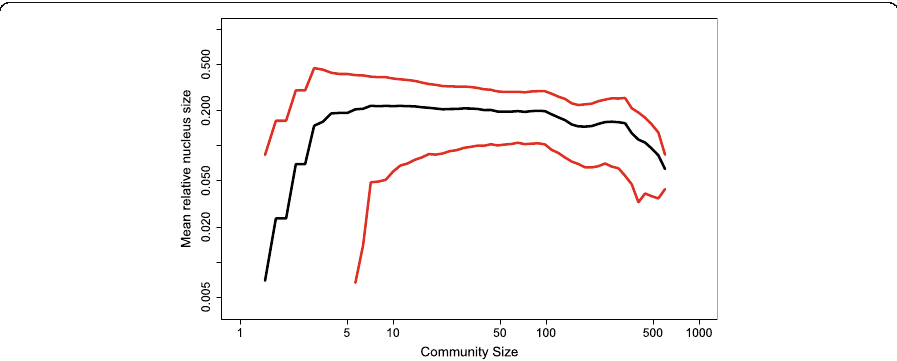
Fig. 9 The average nucleus-to-periphery size ratio is denoted by the black curve. The red curves denote one standard deviation around the